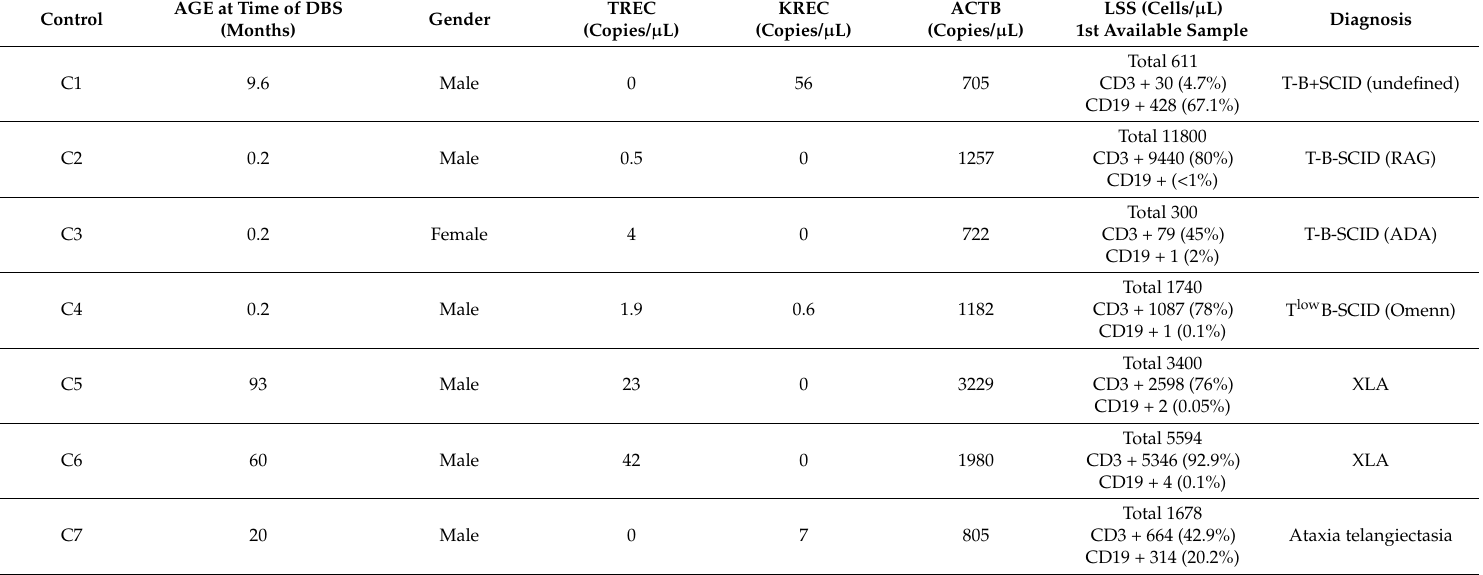
Table 3. Summary from internal positive controls